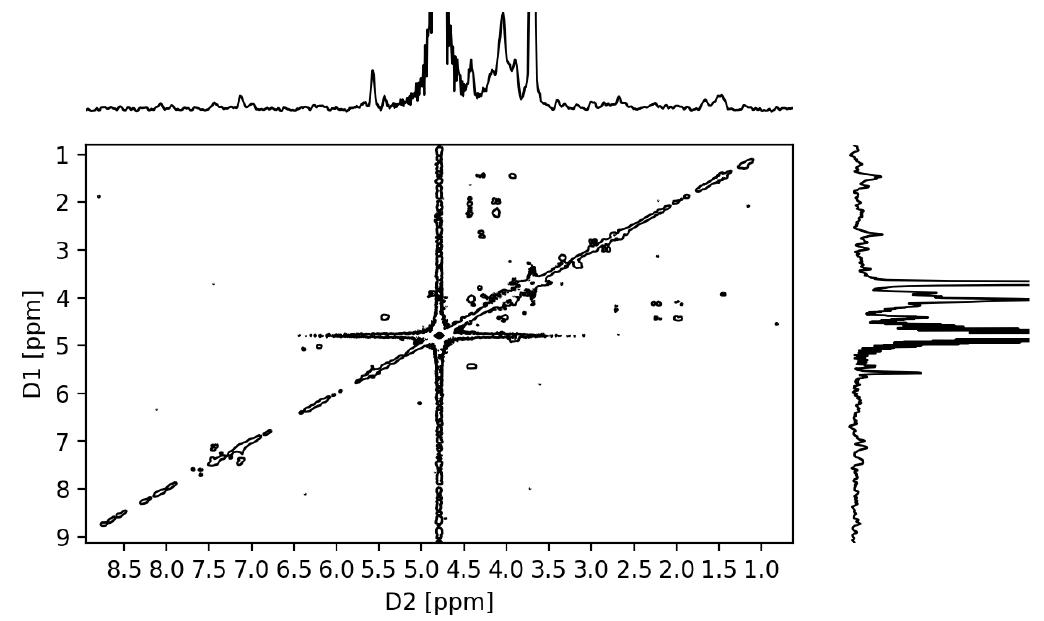
Figure 6. Long-range 1 H- 1 H COSY spectrum of POR-L2 , at 50 °C.